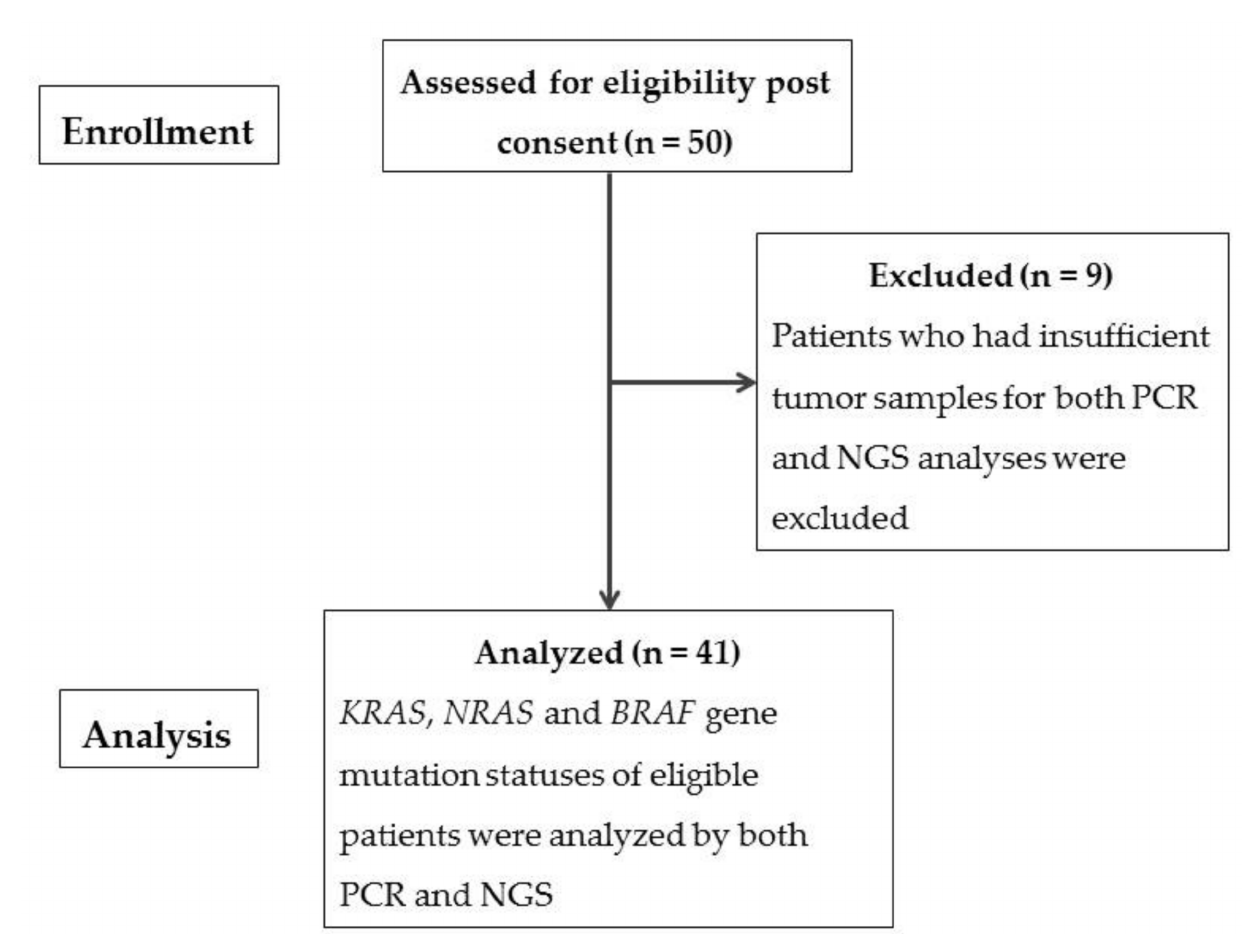
Figure 1. The Consolidated Standards of Reporting Trials (CONSORT) diagram of the present